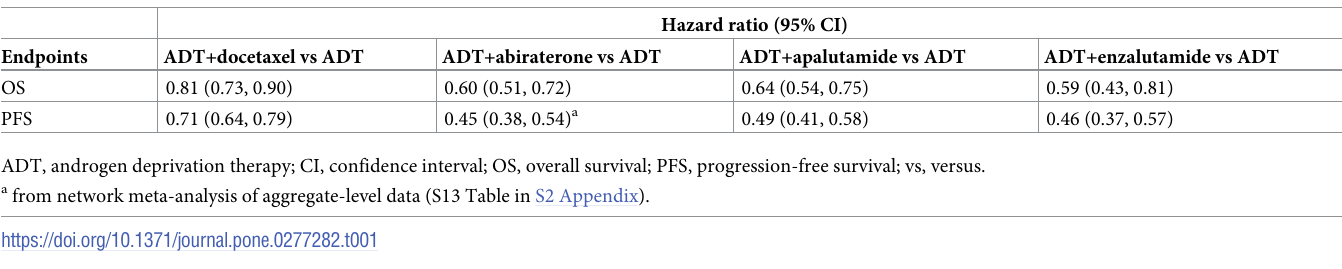
Table 1. Base case hazard